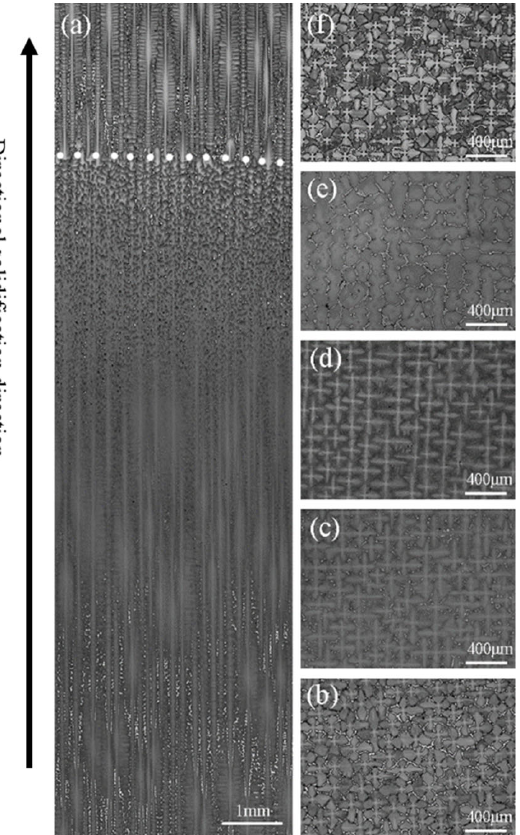
Figure 7. The microstructure of seeding: ( a ) the longitudinal microstructure, and the cross ‐ section microstructures ( b ) before being used for directional solidification, ( c ) of the original zone I, ( d ) of the heat ‐ affected zone II, ( e ) of the mushy zone III, ( f ) of the completely melted zone IV.